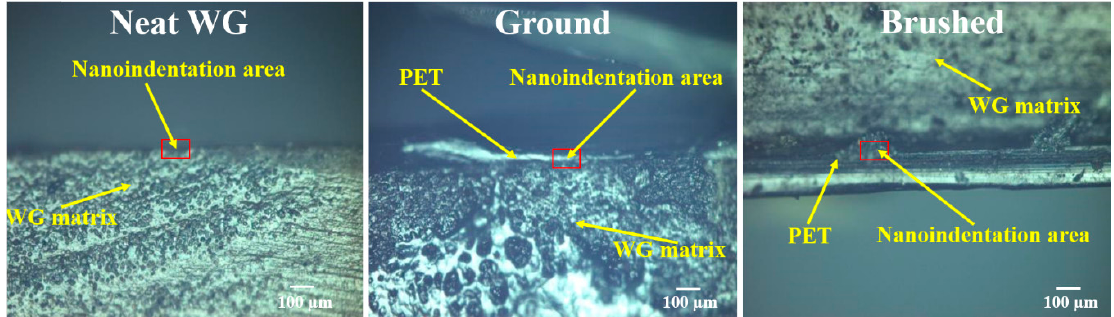
Figure 7. Nanoindentation regions of the cross-sectional samples.